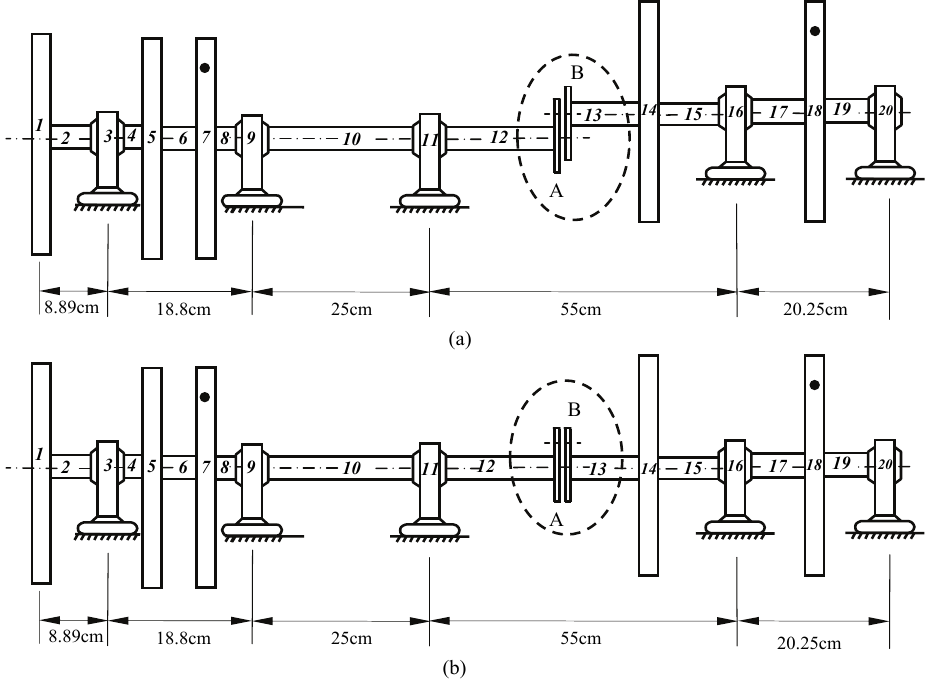
Fig. 4. Example of a misaligned rotor (a) global offset, and (b) local offset, • : unbalanced mass.